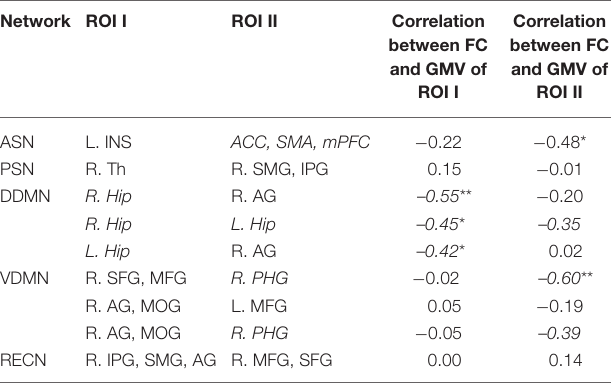
TABLE 4 | The relationship between gray matter volume and functional connectivity in each network in the AUD group. Network ROI I ROI II Correlation